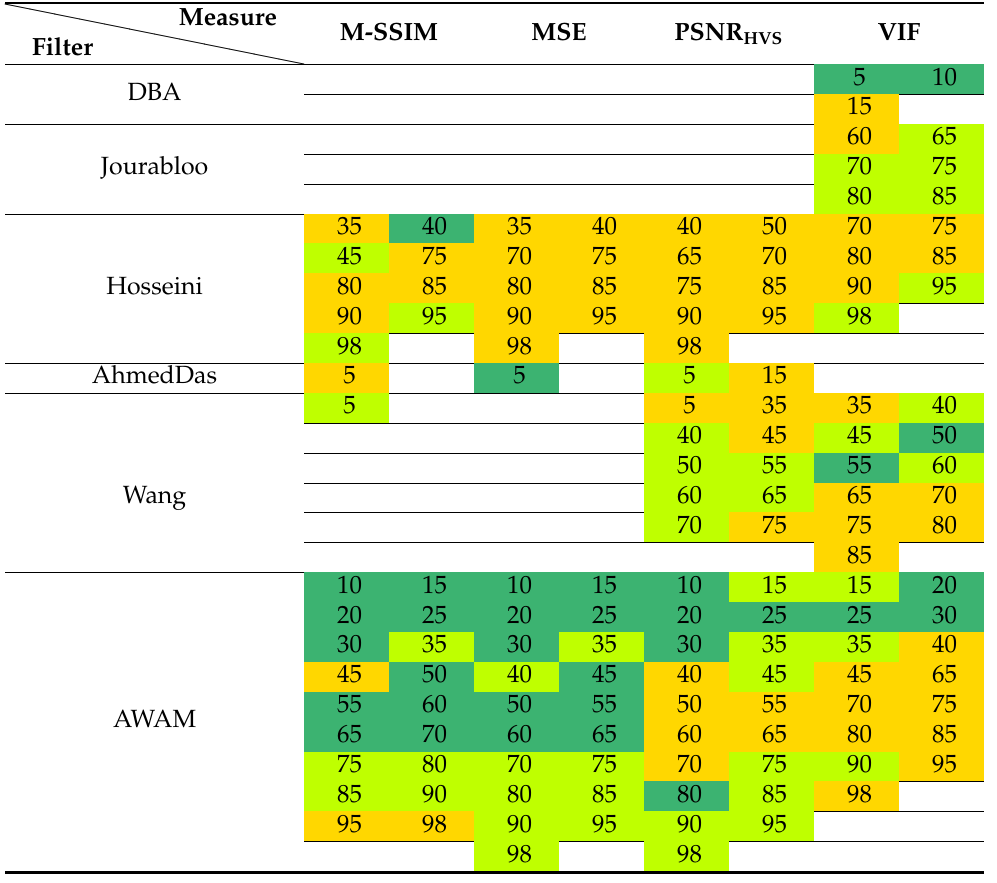
Table 2. Densities of salt-and-pepper noise for which the row filter is not surpassed by any of the rest in accordance with the Wilcoxon test. A green cell implies that the filter obtains the greatest mean value for that noise density, significantly outperforming the competitors in accordance with the Wilcoxon test. On the other hand, a lime cell implies that although the filter achieves the greatest mean value for that noise density, the difference is not significant according to the Wilcoxon test with respect to those filters coloured in